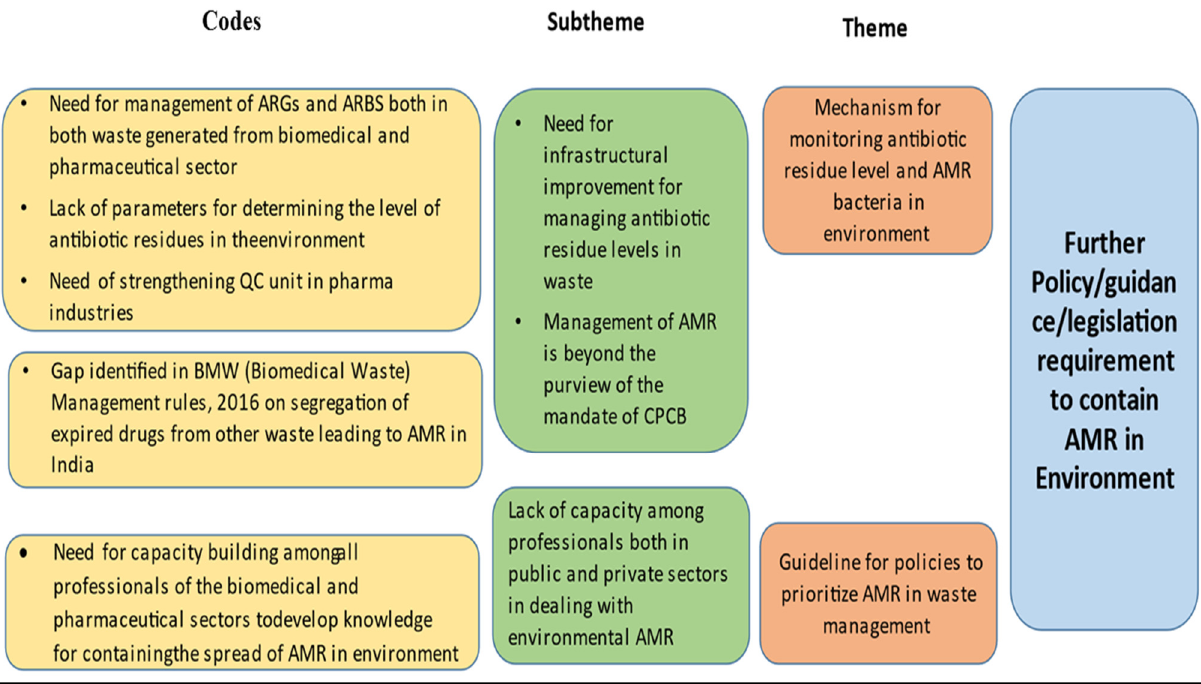
Figure 3. Thematic areas for intervention in biomedical waste management and pharmaceutical waste management.